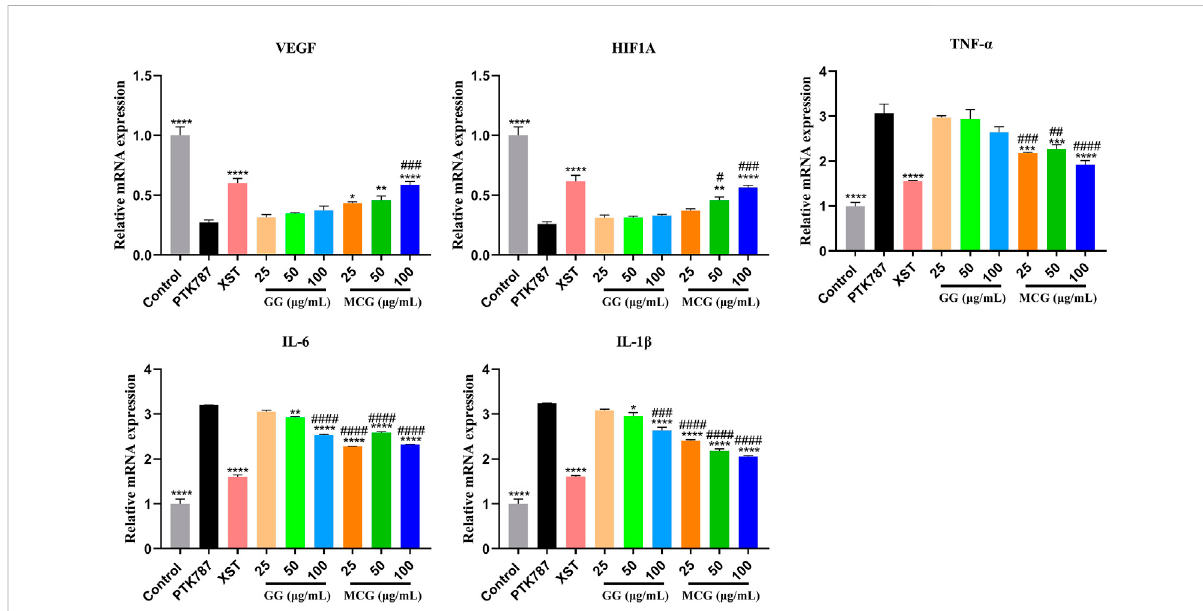
1 β .Dataarerepresentedasthemean±standarderrorofthemean. n =3.* p < 0.05,** p < 0.01,*** p < 0.001,**** p < 0.0001versusthePTK787group; ## p < 0.01, ### p < 0.001, #### p < 0.0001 compared with the GG (25 μ g/ml)-treated